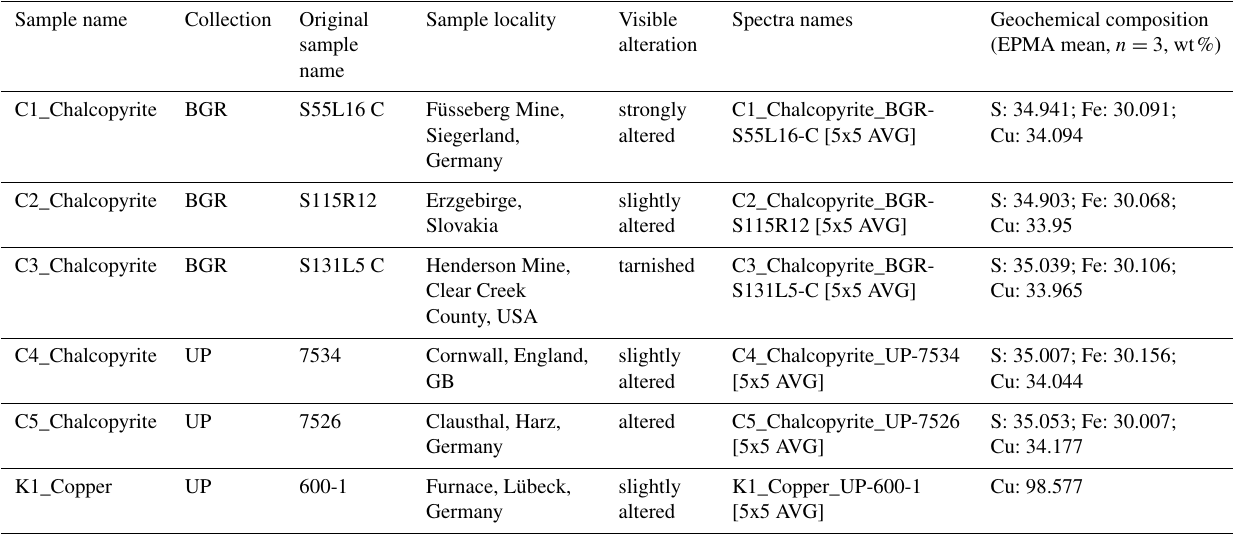
Table 10. Sample names, collection, original sample name, locality, alteration, mineral formula, spectral library filenames and geochemical composition of the copper-bearing sulfides and native